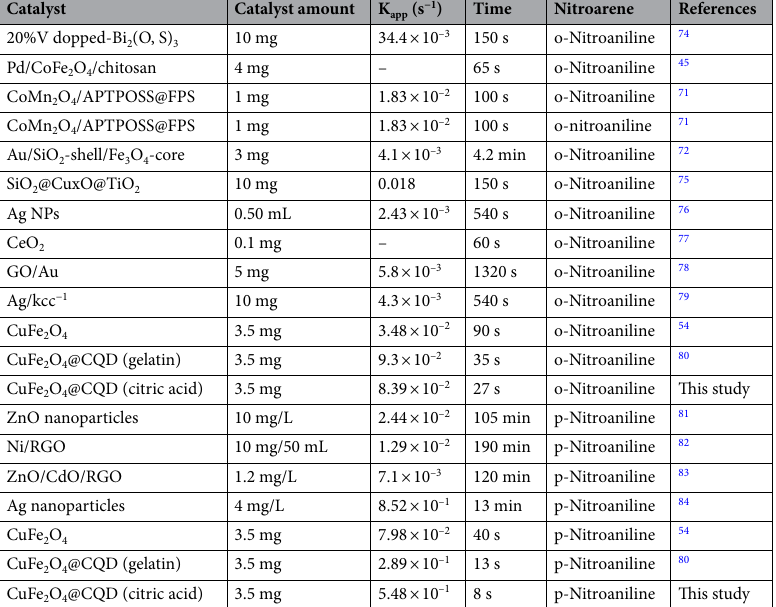
Table 3. Comparison of the constant rate of other catalysts used for reduction of o-NA and p-NA.